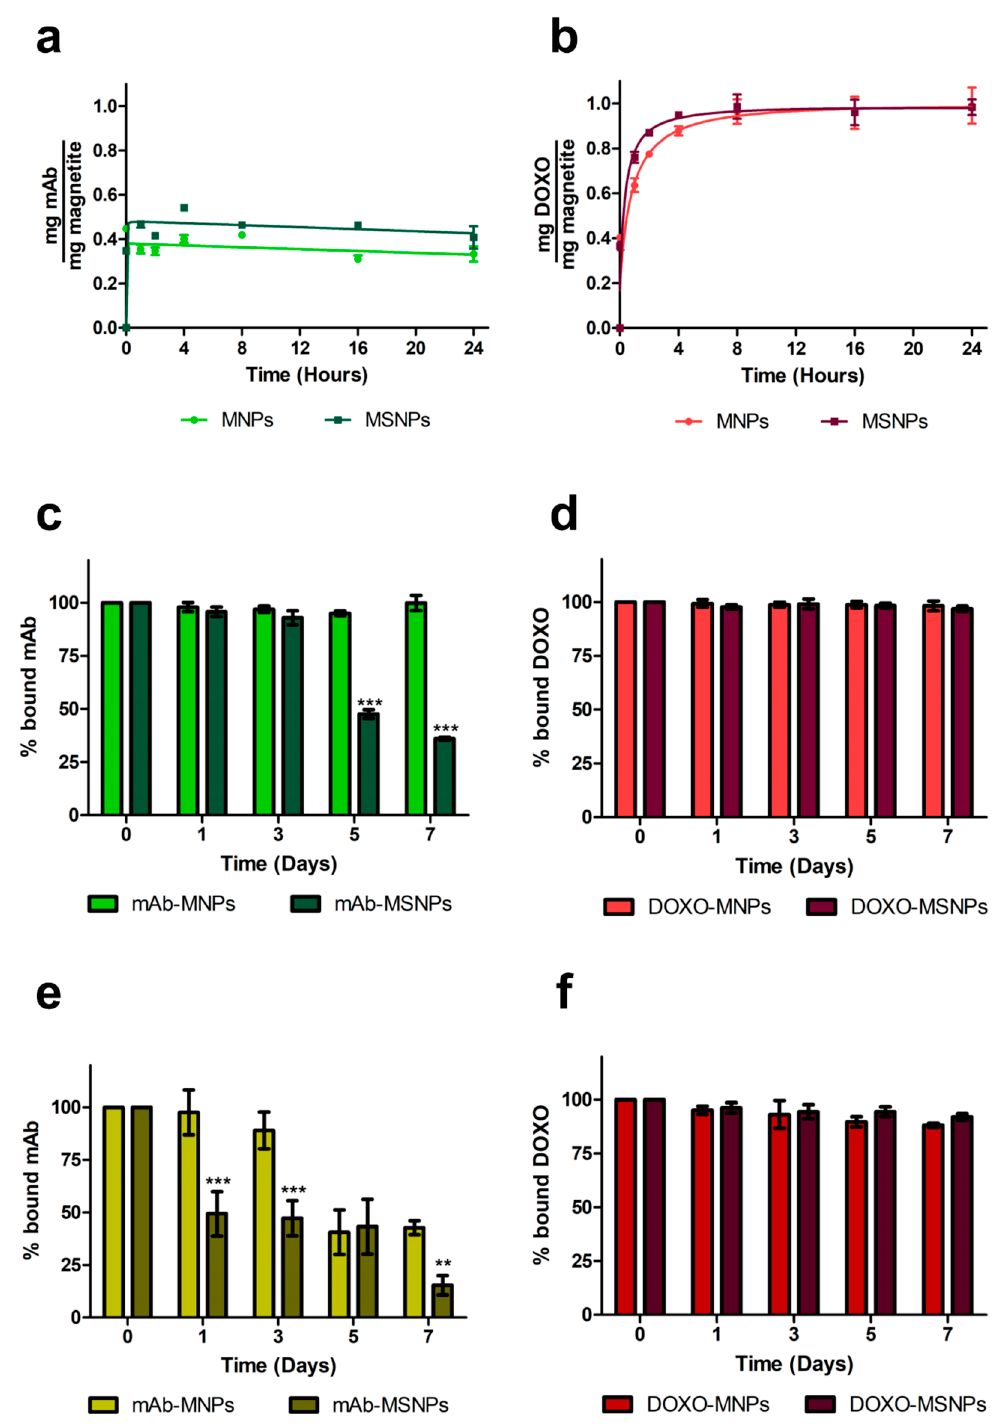
Figure 3. Functionalization of magnetic nanoparticles and stability of the complexes. Nanoparticles were incubated for different times under constant stirring (200 rpm) at 37 °C with DO-24 monoclonal antibodies (mAbs) ( a ) or doxorubicin (DOXO) ( b ) for isothermal adsorption. The washed complexes (mAb-NPs, c and e and DOXO-MNPs, d and f ) were then incubated for different times under constant stirring (200 rpm) at 37 °C in PBS not containing ( c , d ) or containing ( e , f ) 10% FCS. The particulate and the soluble fractions were separated through a magnet and mAb bound on nanoparticles was estimated in SDS-PAGE and WB (A), while DOXO bound was calculated by subtracting the amount detected in the soluble fraction (B). For statistical analysis the treatments were compared between each other at each time point (*** p < 0.001).